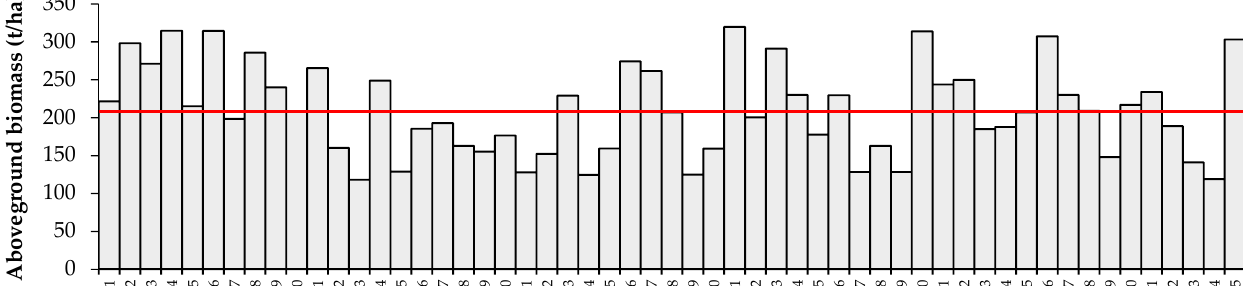
Sample plots Figure 3. The value of the aboveground biomass for each plot. The red line shows the mean value of aboveground biomass (AGB) at the study level. Table 2. Pearson’s correlation coefficient (r) between spectral information and the aboveground bi- omass (AGB).